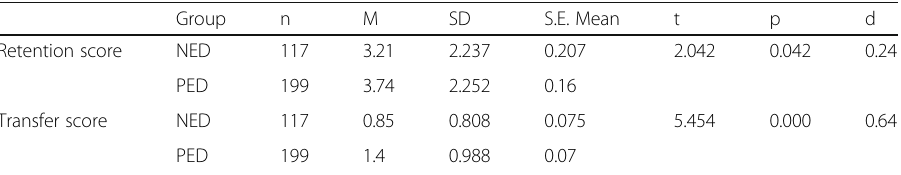
Table 1 Mean and standard deviation values of retention and transfer scores for two groups Group n M SD S.E. Mean t p d Retention score NED 117 3.21 2.237 0.207 0.24 PED 199 3.74 2.252 0.16 Transfer score NED 117 0.85 0.808 0.64 PED 199 1.4 0.988